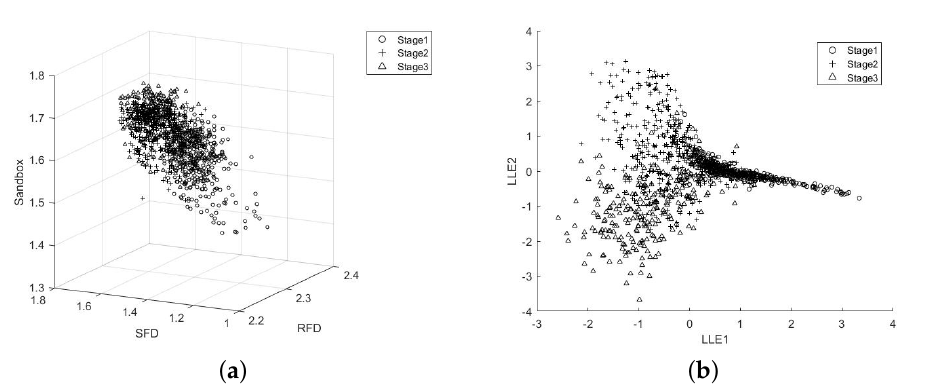
Figure A2. scatter plots to speculate the manifold characteristics using LLE algorithm. The round points represent tillering stag, the cross-shaped points represent booting and jointing transition period, and the triangular points represent heading and grain filling transition period. ( a ) Fractal dimension scatter plot. ( b ) LLE dimensionality reduction